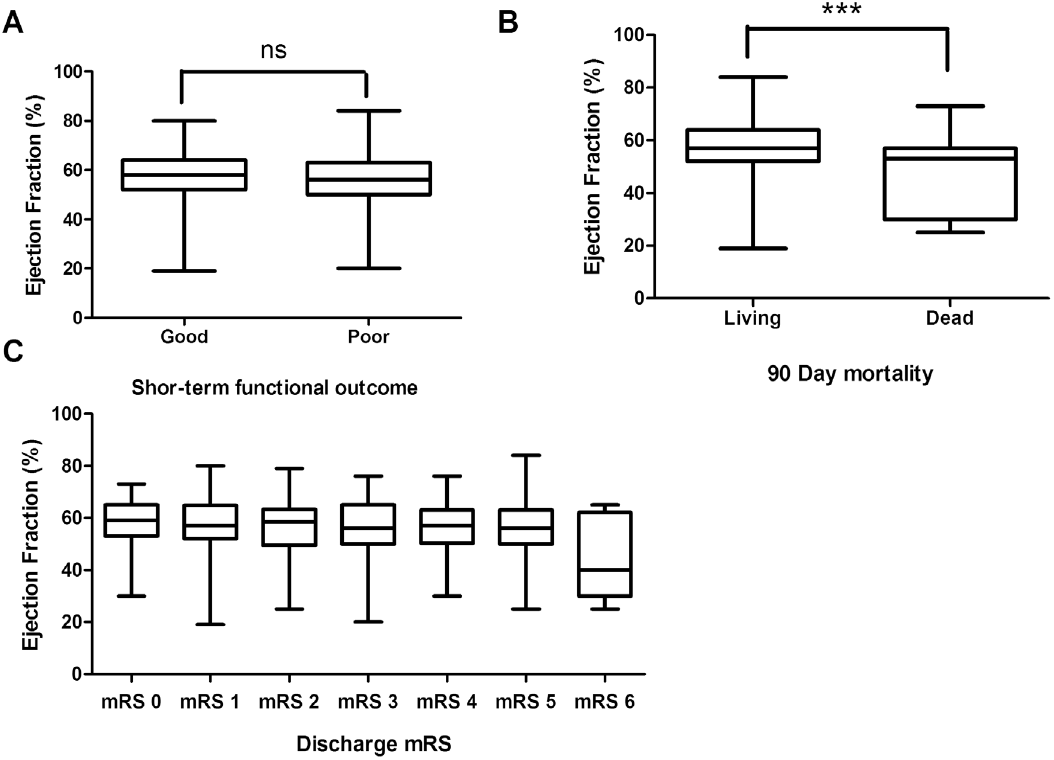
Figure 3. EF according to short-term functional outcome (A), 90 days mortality (B), and mRS in CES patients (C). p-value , 0.01. Abbreviations: ns: not significant, EF, Ejection fraction.mRS: modified Rankin Scale, CES: Cardioembolic stroke.